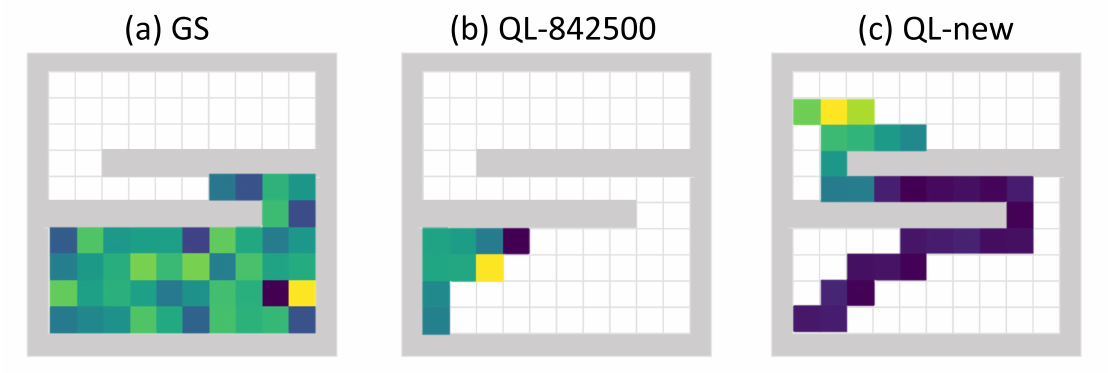
Figure 11. Detector trapping test 2. In this trapping test, a simulation area with two overlapped long walls was tested. The relative trapped time was defined as the percentage of the time the detector stayed in the lower 60% part of the simulation area during the whole searching process. For all the searching path examples, the detector initialization point was at the lower left corner, the radiation source was at the upper left corner, and the color of the path represents the mean radiation intensity (blue is low, and yellow is high). Plot ( a ) shows an example search path from the gradient search method that was failed to find the source. Plot ( b ) shows an example search path from the Q-learning model taken from the 842,500th episode, and this search was also failed to find the source. Plot ( c ) shows an example search path from the Q-learning model that was trained for additional 6000 episodes on the new simulation area. After this additional training, the new Q-learning model was able to efficiently search for sources in the new